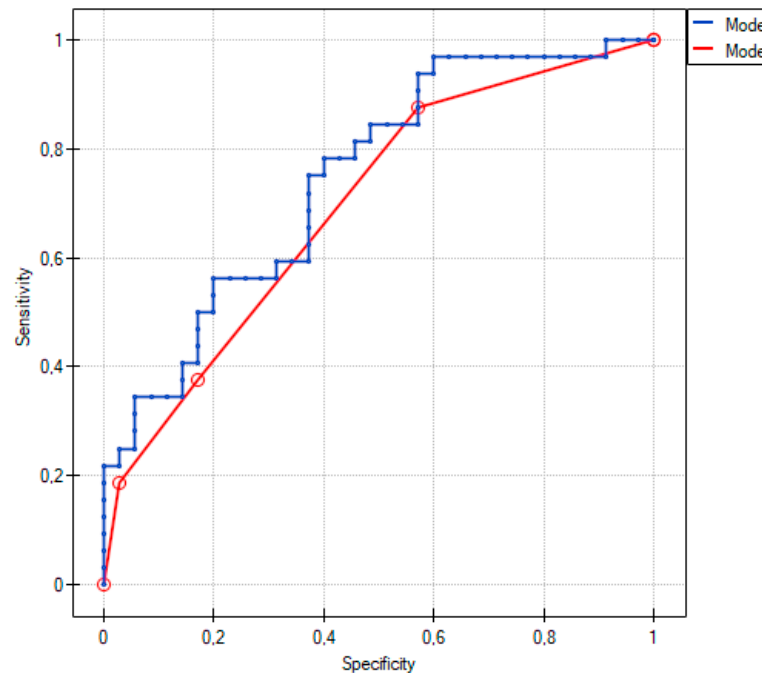
Figure 1. Comparison of logistic regression models between Group 1 and Group 2.